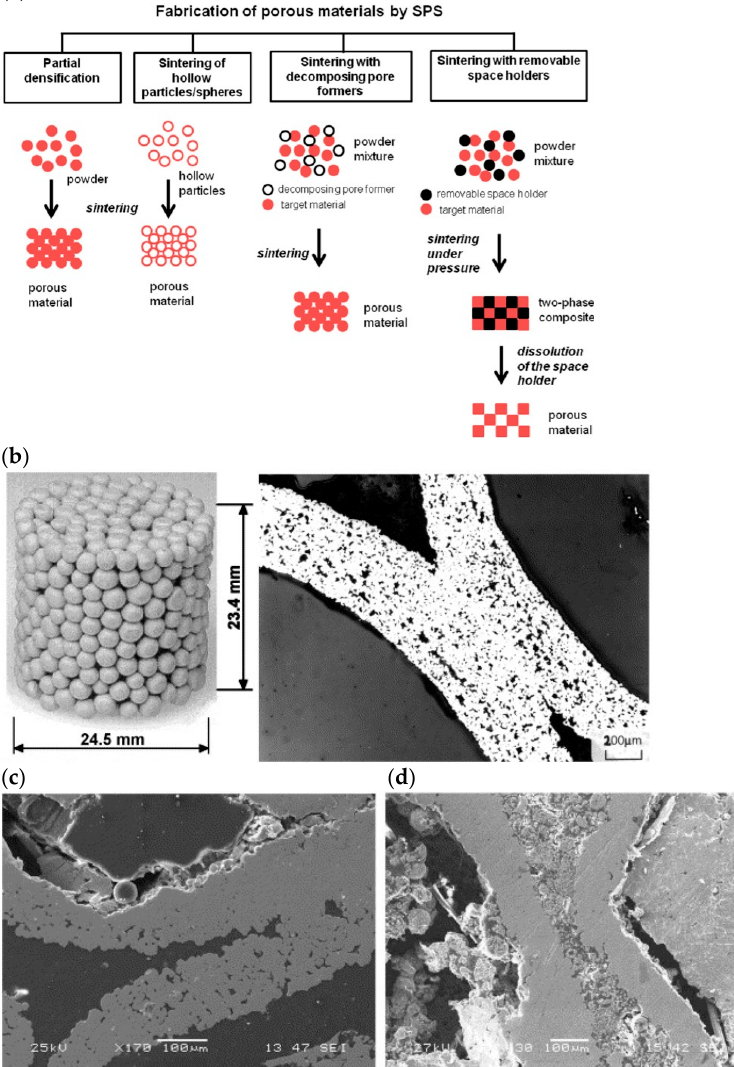
Figure 8. ( a ) Schematic illustrating approaches to the fabrication of porous materials by SPS. Open re-prints from reference [47], ( b ) Outline and optical micrograph of the randomly packed hollow sphere before SPS, and SEM micrographs of randomly packed hollow sphere SPS treated at ( c ) 1100 °C and ( d ) 1200 °C. Reproduced with permission from reference [52].